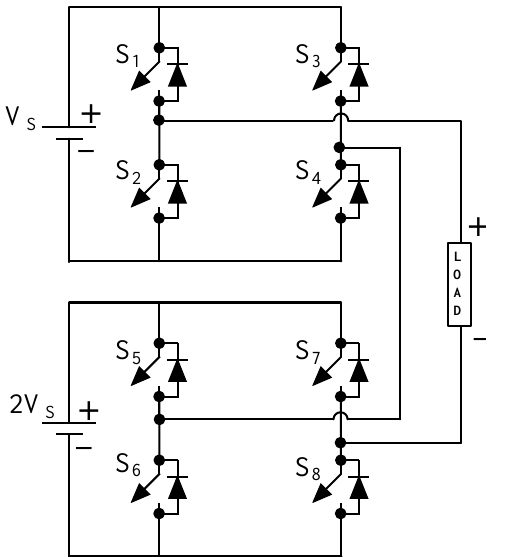
Figure 1. Quasi-linear MLI (n = 7).